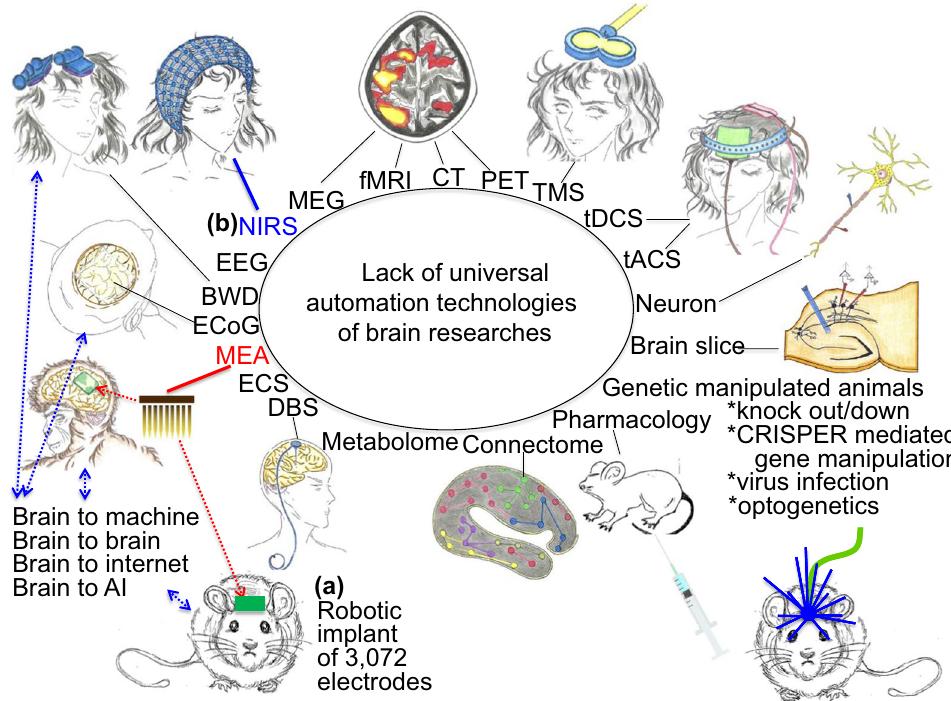
Fig. 1 Lack of automation in brain research. The various methods in brain research described below are not automatized or technically interconnected with each other. Two approaches exist in vivo: non-invasive and invasive approaches. Non-invasive technologies, such as positron emission tomography (PET), computed tomography (CT), functional magnetic resonance imaging (fMRI), magnetoencephalography (MEG), near-infrared spectroscopy (NIRS), and electroencephalography (EEG), measure brain activities via different principals (Rothschild 2010), whereas transcranial magnetic stimulation (TMS), transcranial direct current stimulation (tDCS), and transcranial alternating current stimulation (tACS), broadly stimulate the brain (Miranda 2013). These non-invasive technologies are not interconnected and cannot evaluate or stimulate individual neuronal activity. Genetically manipulated animals, including knockout, knockdown, or overexpressed mice, and pharmacological approaches are also categorized as in vivo non-invasive brain research. Conversely, electrocorticography (ECoG), an in vivo invasive technology, simultaneously stimulates and records broad areas of the brain cortex (Rothschild 2010). Other in vivo invasive approaches, such as microelectrode arrays (MEA), electrical cortical stimulation (ECS), and deep brain stimulation (DBS), enable the direct stimulation and recording of neuronal activities (Rothschild 2010). Optogenetic manipulation is categorized as in vivo invasive technology that directly stimulates or suppresses neuronal activities, because blue light, which is necessary for optogenetics, must be supplied under the skull incision (Chen et al. 2018). Of note, digital data obtained by ECoG or MEA can be interconnected with data from other animals and robots via the Internet (Lebedev et al. 2005). Furthermore, the brown